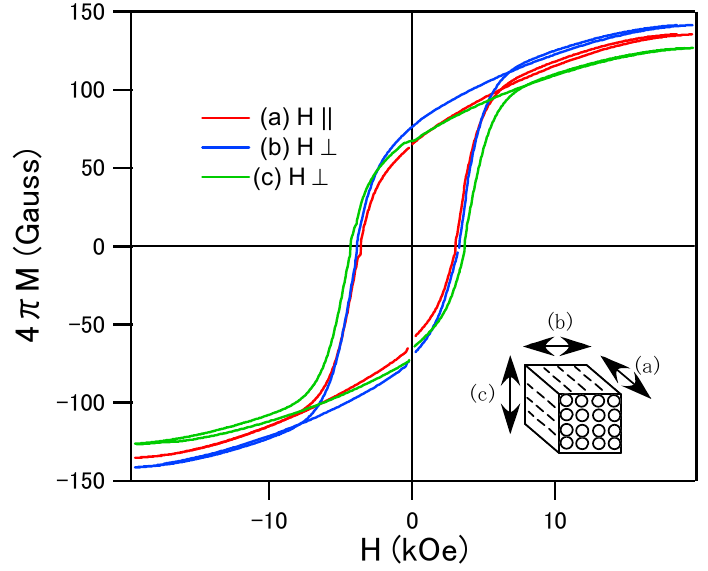
Figure 4. Magnetic hysteresis loops of the porous specimens sintered at 1200 °C in (a), (b) and (c)